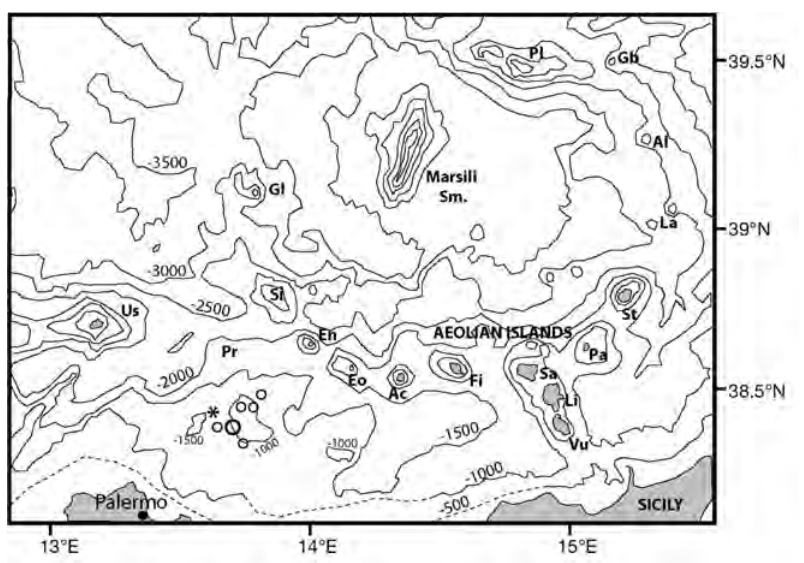
Fig. 1. Sketch of the Southern Tyrrhenian Sea (redrawn simplified from Marani et al. , 2004b,c), including coastlines and isobaths (every 500 m). All the volcanic islands (in grey in the figure) and submerged seamounts are indicated, except the Vavilov seamount that lies at NW out of the map. Proceeding from NE counter-clock- wise: Pl – Palinuro; Gb – Glabro; Al – Alcione; La – Lametini; St – Stromboli; Pa – Panarea; Vu – Vulcano; Li – Lipari; Sa – Salina; Fi – Filicudi; Ac – Alicudi; Eo – Eolo; En – Enarete; Pr – Prometeo; Us – Ustica; Si – Sisi- fo; Gl – Glauco (Marani and Gamberi, 2004; Trua et al. , 2004). The circles represent the main shock ( M w 5.9) and its most energetic aftershocks according to table II, where the errors in km can be found. The star indicates the cable failure